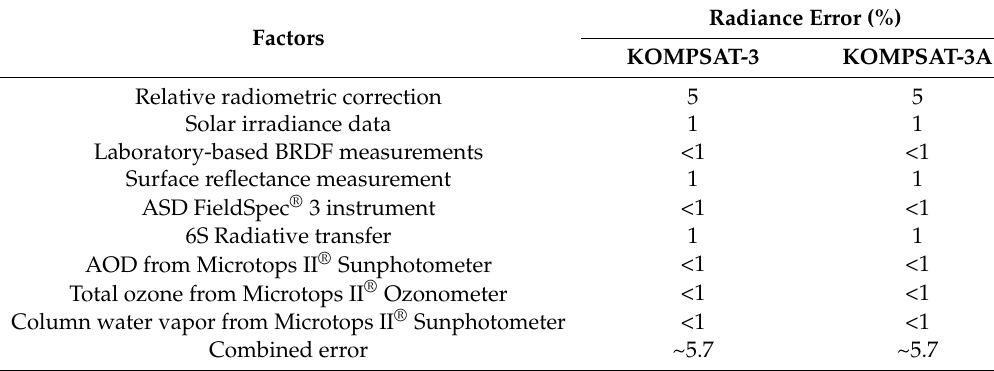
Table 6. Approximate error budget for the vicarious calibration of KOMPSAT-3 and